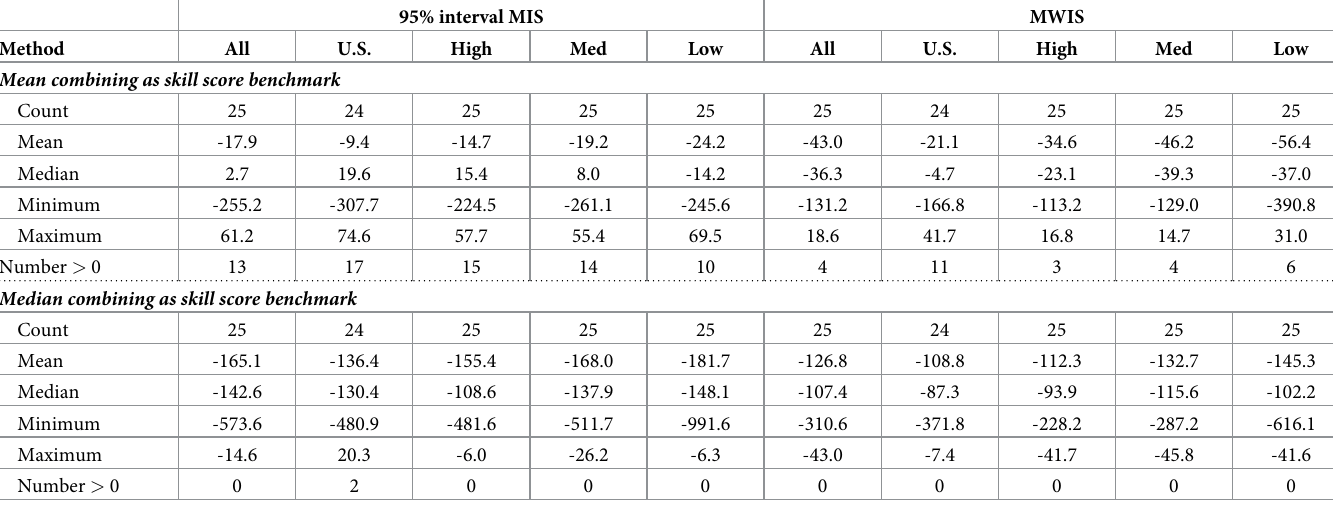
Table 12. For cumulative mortality, summary statistics of skill scores for individual models, using mean and median combining as benchmark.